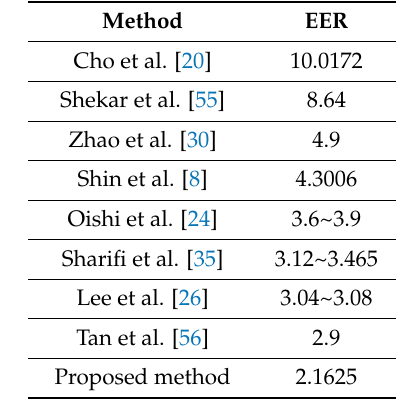
Table 7. Comparative EERs on CASIA-Iris-Distance database (unit: %).